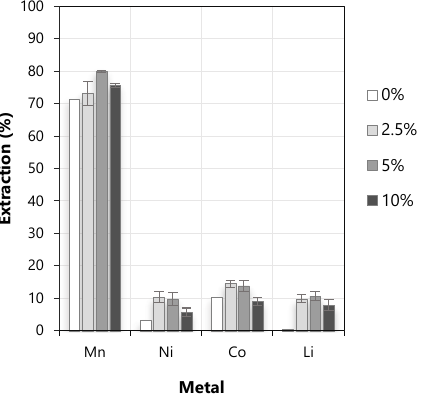
Figure 2. Extraction of metals using different volumetric concentrations of TBP as a phase modifier. Conditions: contact time of 10 min, 0.5 M D2EHPA, equilibrium pH of 3.5, organic to aqueous ratio (O:A) of 1:1. Error bars represent the standard deviation of